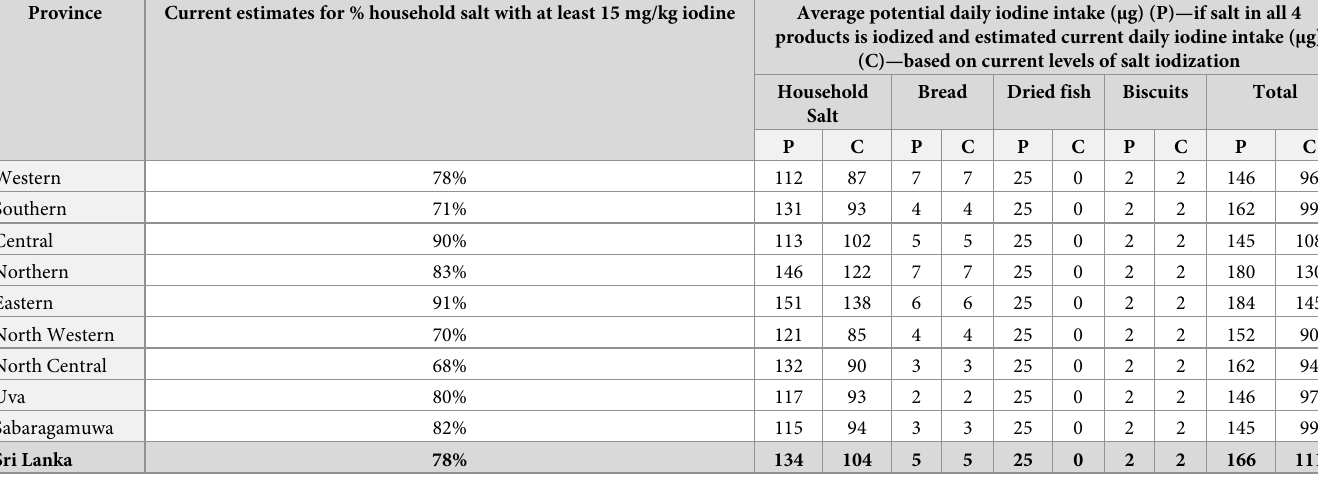
Table 3. Estimated potential (P) and current (C) daily iodine intake ( μ g) from household salt and commonly consumed IPF in non-pregnant adults.